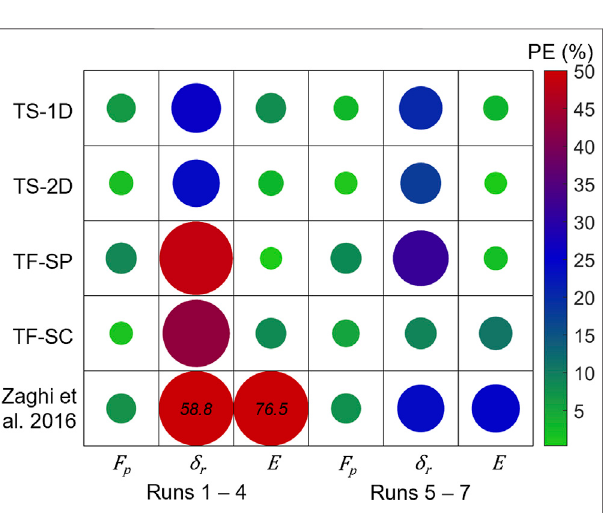
and Figure 10B , respectively. The energy dissipation was calculated by integrating the measured force-displacement hysteresis curves. The time between cycles was removed for presentation purposes. The R 2 values were calculated using the predicted force and energy and the measured lateral force and dissipated energy to demonstrate the accuracy across the time histories. The R 2 values for the lateral force were 0.947, 0.976, 0.852, 0.926, and 0.936 for TS-1D, TS-1D, TF-SP, TF-SC, and the Reference Model, respectively. The R 2 values for the dissipated energy were 0.993, 0.997, 0.996, 0.924, and 0.831 for TS-1D, TS-